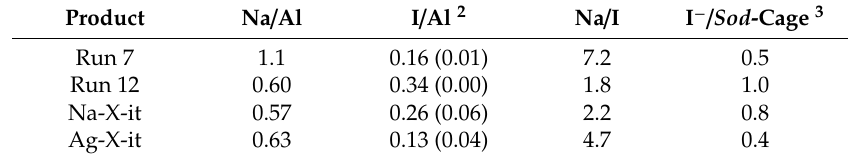
Table 2. Chemical composition of the selected products synthesized by interzeolite transformation 1